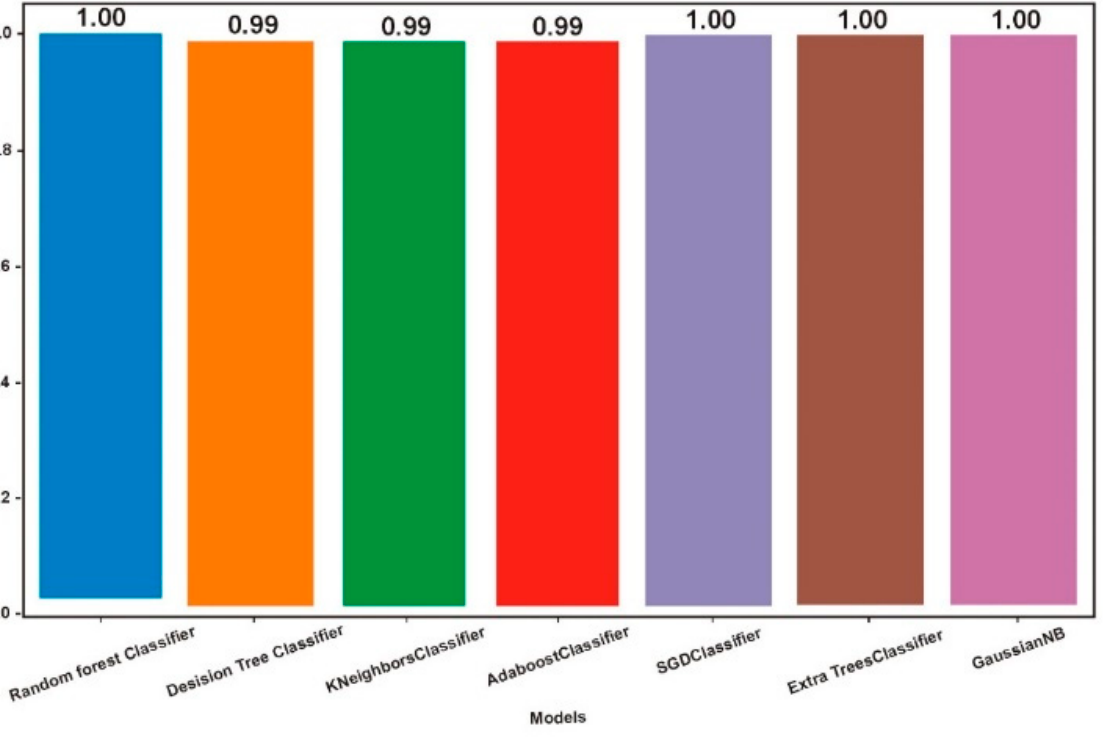
Figure 9. RF, SGD, extra trees and Gaussian NB Model.